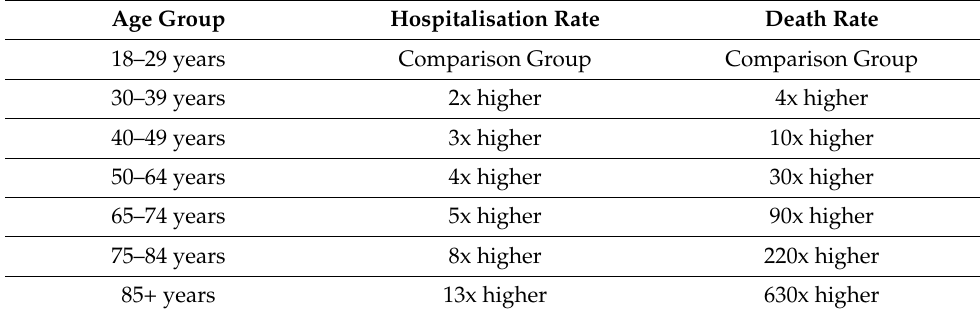
Table 1. COVID-19 hospitalisation and death rates, USA, for age groups 18–29 to